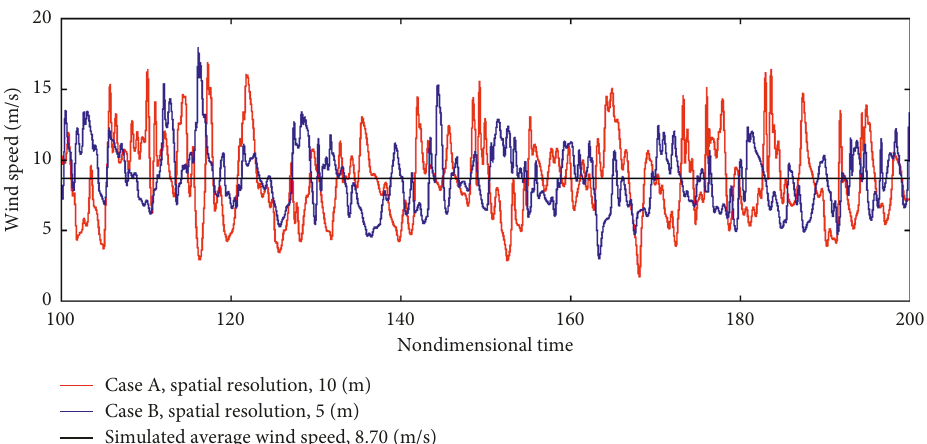
Figure 13: Time variation of wind speed in the computational simulation of wind conditions and comparison of spatial resolutions of 10m and 5m at 5m above